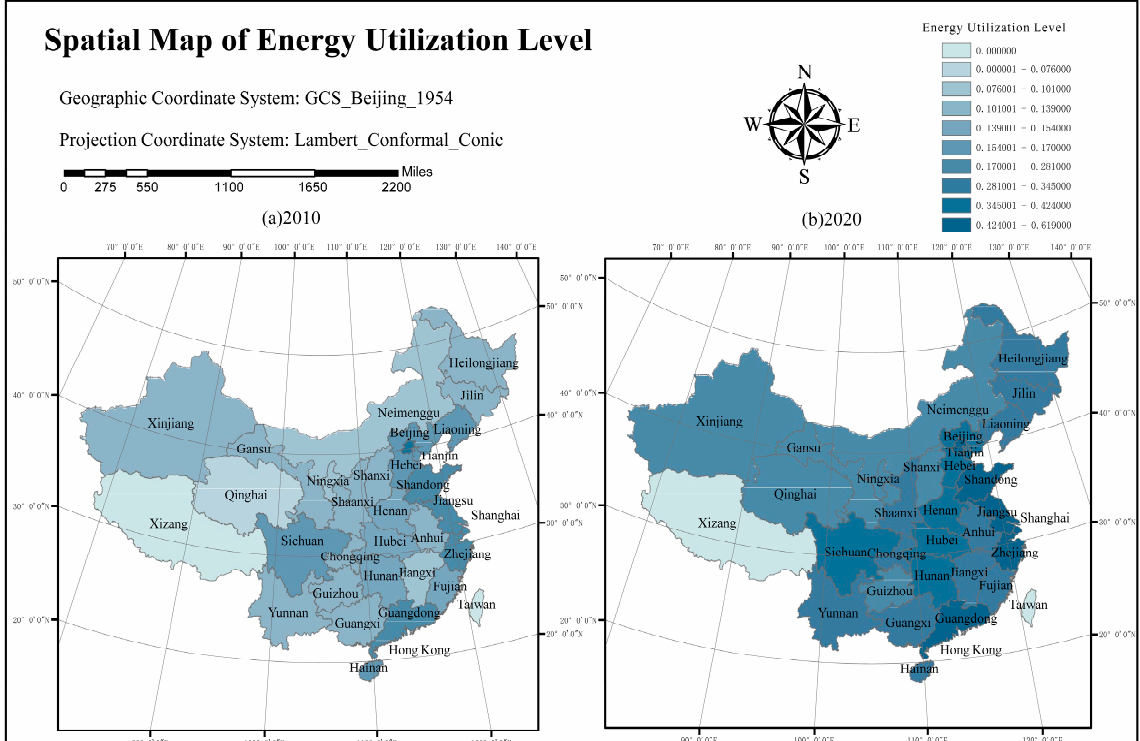
Figure 2. Spatiotemporal differentiation diagram of energy utilization level. Note: The islands in the South China Sea are not shown in the figure.